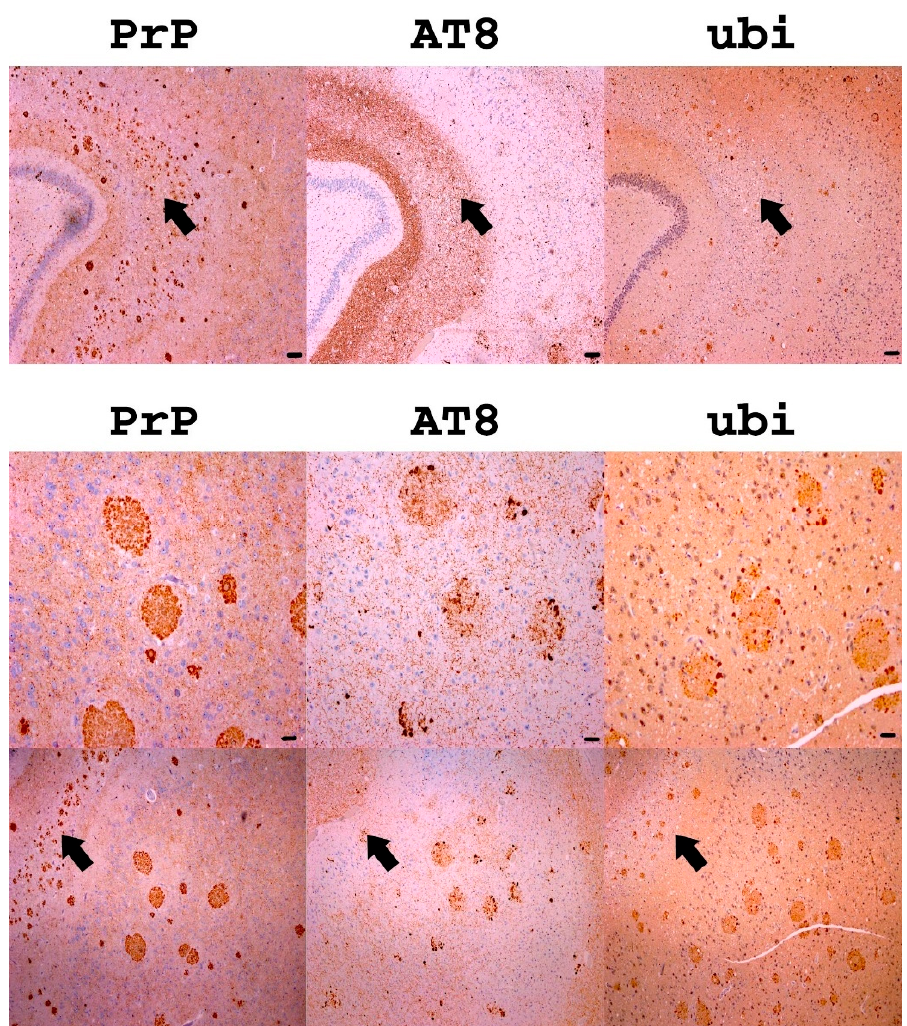
Figure 2. The top half—Immunohistochemistry observation of PrP, hyperphosphorylated protein tau, and ubiquitin in the CA1–CA2 area. No expression of hyperphosphorylated protein tau (AT8 antibody clone) and negligible ubiquitin expression was observed in areas with abundant small PrP aggregates. The magnification is 40× and the scale bars indicate 100 µm. The bottom half—Immunohistochemistry observation of PrP, hyperphosphorylated protein tau, and ubiquitin in large plaques in CA1. Bulbous changes in dystrophic neurites stained by AT8 and ubiquitin antibody were observed, but only in large PrP plaques of one particular subject; there was no co-expression in other areas (see arrows). All images come from subject no. 7. The images in the top row are zoomed details from the bottom row. The scale bars in the top row indicate 20 µm. The scale bars in the bottom row indicate 100 µm. Magnification is 100× and 40×, respectively.